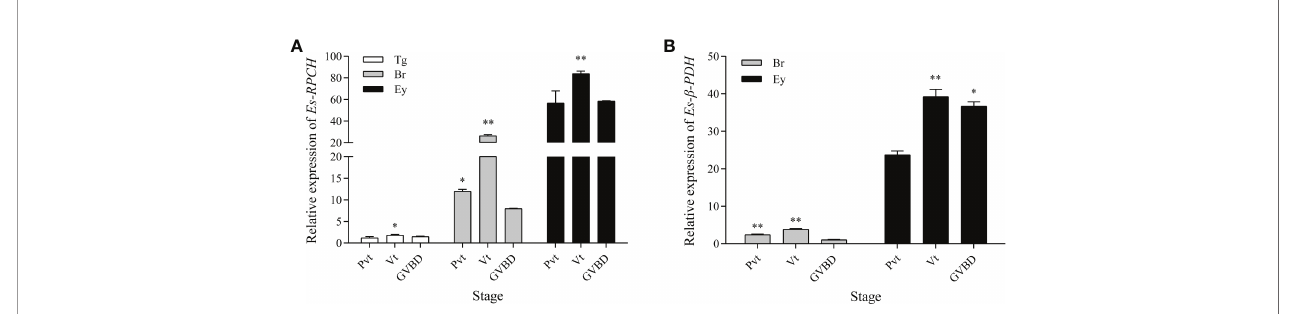
FIGURE 4 | qPCR assay of the relative expression level of Es-RPCH (A) and Es- b -PDH (B) mRNA in the thoracic ganglia (Tg), brain (Br);, eyestalks (Ey) during ovarian development in E. sinensis. Ovarian stages are divided into previtellogenic (Pvt), vitellogenic (Vt) and germinal vesicle breakdown (GVBD) stages. The data are presented as the means + SD ( n = 3 ). * represents signi fi cant difference ( P < 0.05), and ** represents highly signi fi cant difference ( P